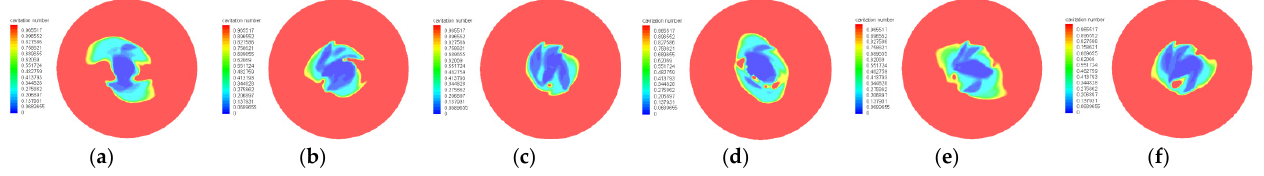
Figure 27. When inlet pressure = 15 MPa, gap = 1.5 mm, the variation of cavitation number of suction cup- θ 20 with time in adhesion interface plane at: ( a ) 5 ms, ( b ) 9.4 € ( c ) 13.8 ms, ( d ) 18.2 ms, ( e ) 22.6 ms, and ( f ) 27 ms.